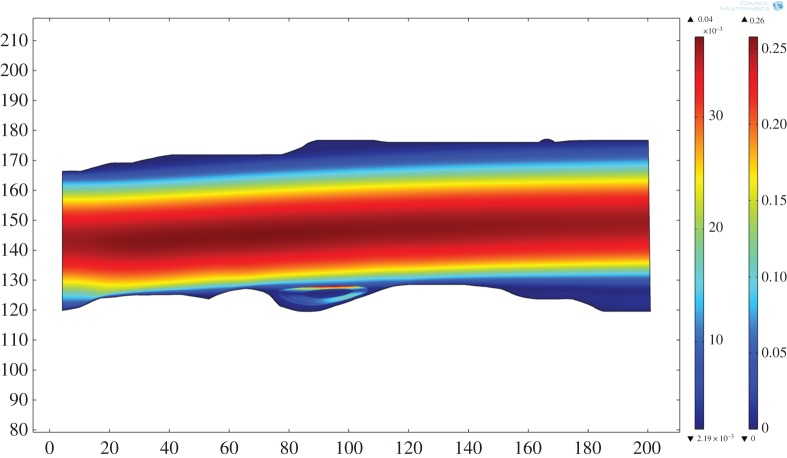
Two-dimensional model simulation of magma flow in the Basement Sill solved in the original (field) geometry. The model recovers the unique surface velocity field for a magma viscosity of 10 Pa s and density of 2500 kg m−3. As expected from standard analytical solutions for Poiseuille-type flow, velocities are fastest in the centre (approx. 0.25 m s−1) and decrease parabolically towards the margins of the intrusion [51]. Note the eddy formed at the lower boundary. Axis units in m.